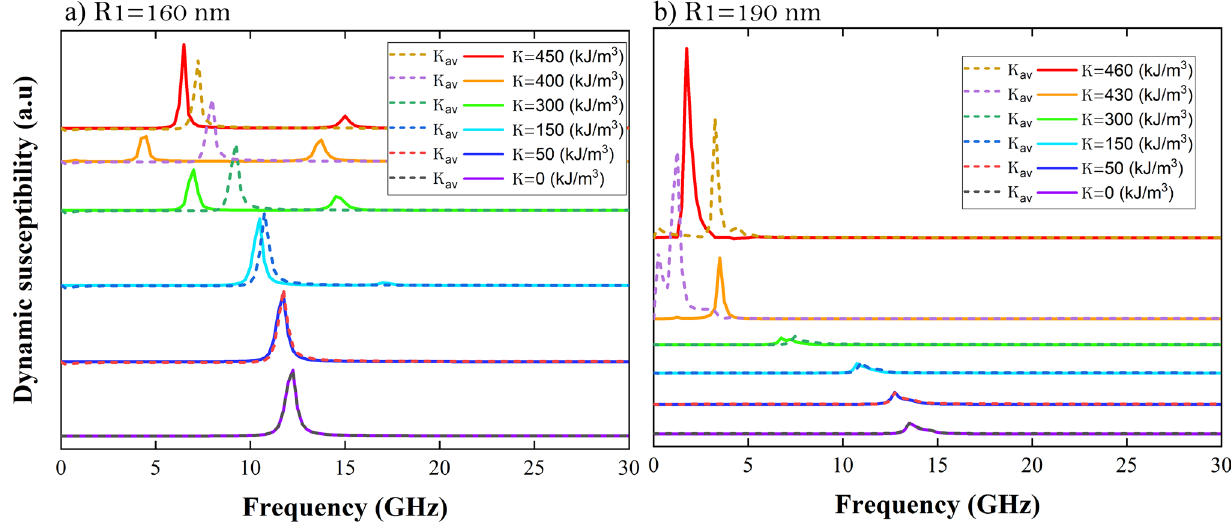
Figure 7. Comparison of the effect of the RPMA respect to a uniform PMA in the resonance spectra for the narrower nanorings with internal radii ( a ) R 1 = 160 and ( b ) R 2 = 190 nm due to a magnetic pulse in the x -direction. In these figures, the RPMA curves are shown by solid lines, while the corresponding for the uniform PMA with uniaxial anisotropy constant K av = K / 2 are depicted by dashed